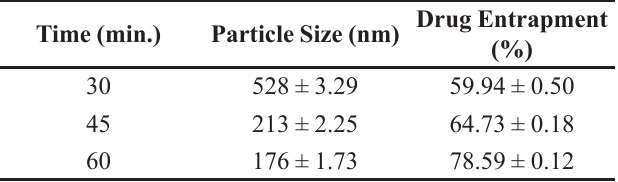
TABLE V - Optimization of Stirring Time Time (min.)